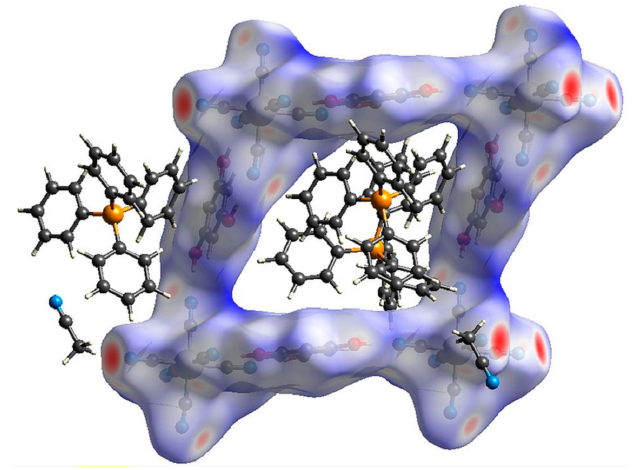
Figure 3. Hirshfeld surface presenting contacts formed by the anion subnetwork grid.